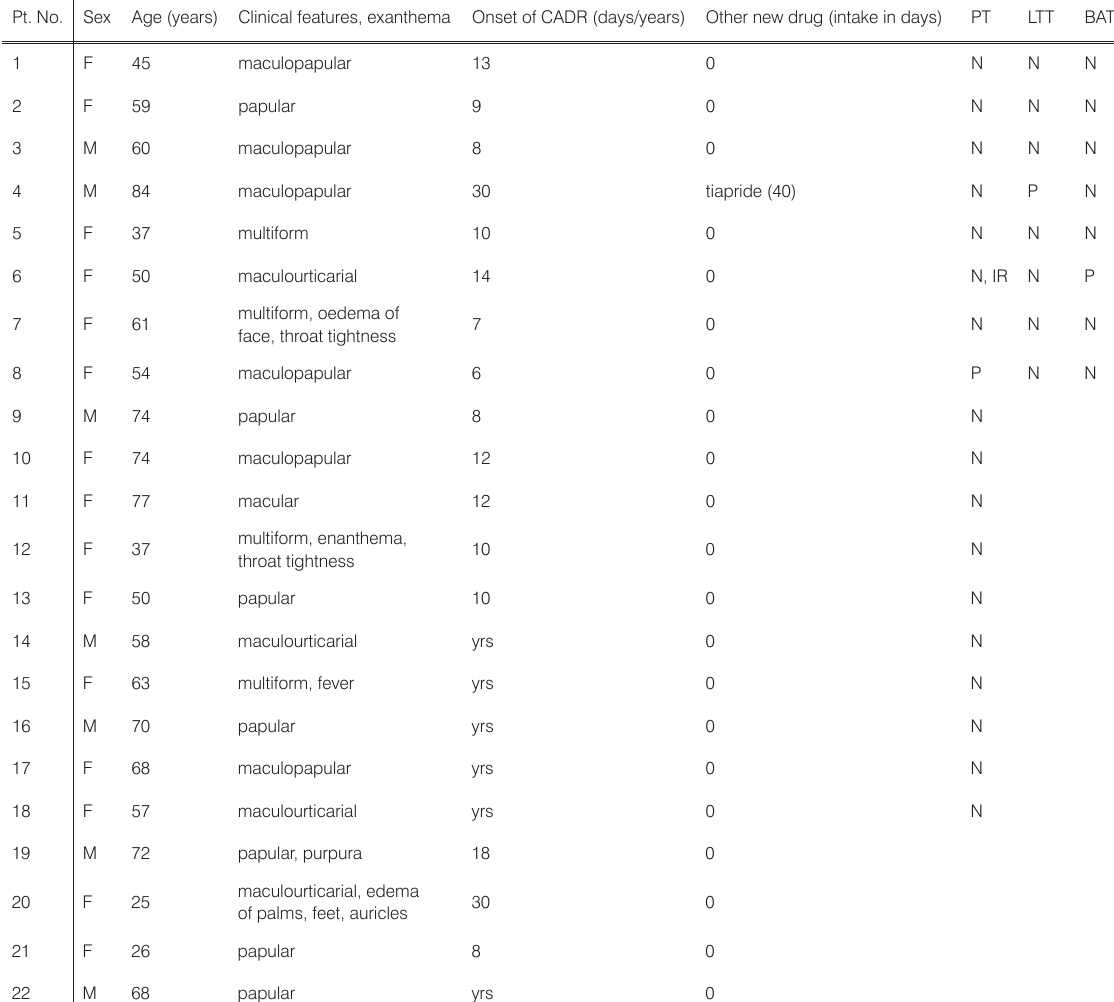
Table 1. Characterization of patients. Pt. – patient, N – negative, P – positive, M – male, F – female, IR – immediate